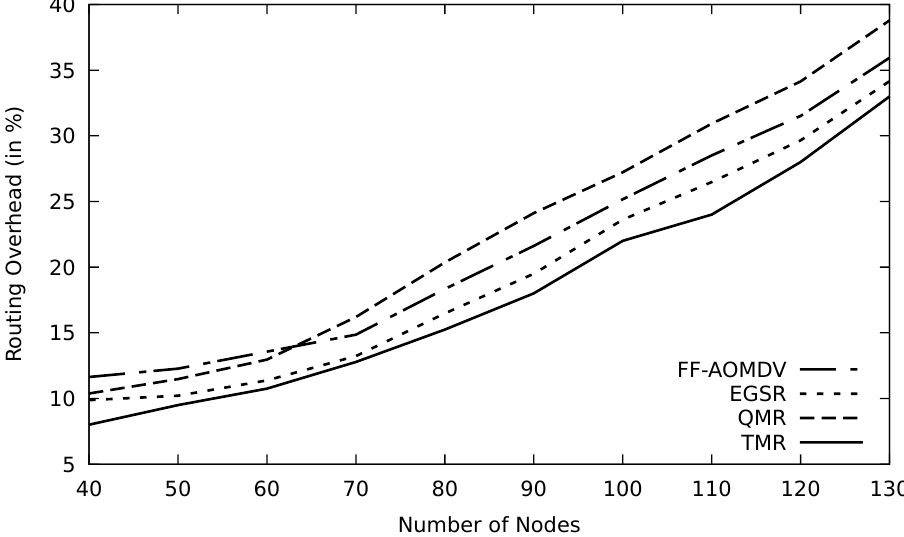
Figure 21. Comparison of FF-AOMDV, EGSR, QMR, and proposed protocol TMR for routing overhead with mobility